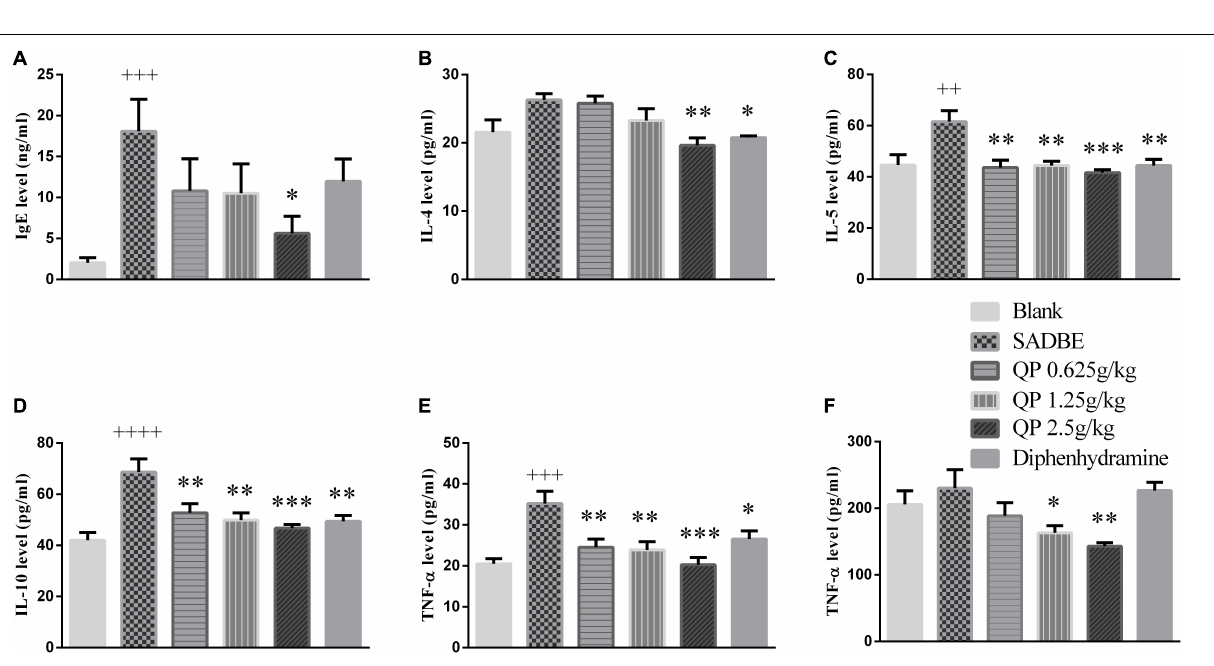
Frontiers in Pharmacology |